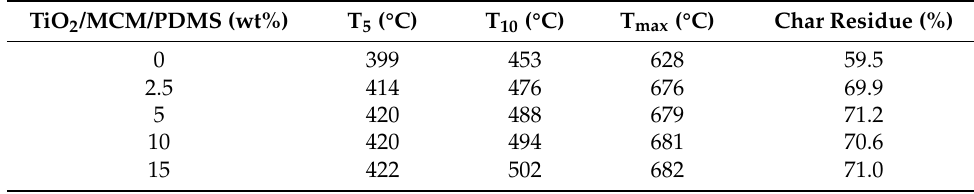
Table 2. Thermal data of TiO 2 /MCM/PDMS composites. TiO 2 /MCM/PDMS (wt%)